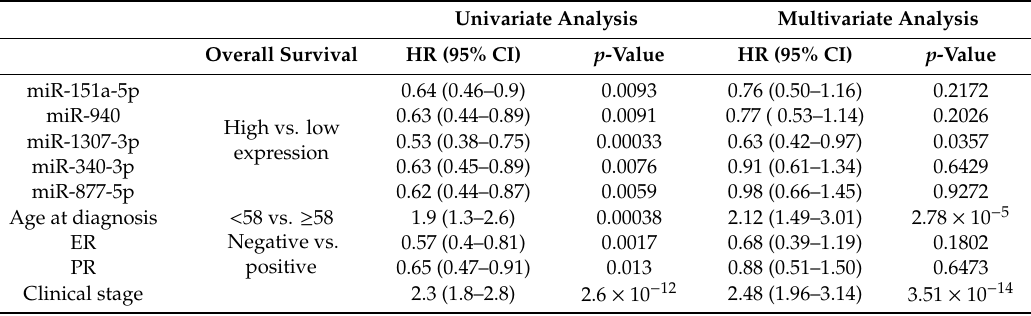
Figure 8. Kaplan–Meier overall survival analysis based on five clinically significant MMRs. ( A ) Shows the differences in the survival of patients with a high and low expression of miR-151a-5p. Blue lines represent patients with a low miRNA expression and red patients with a high expression. ( B ) Survival for miR-340-3p. ( C ) Survival for miR-877-5p. ( D ) Survival for miR-940 and ( E ) Survival for miR-1307-3p. Table 3. Cox regression analysis of the overall survival of the breast cancer